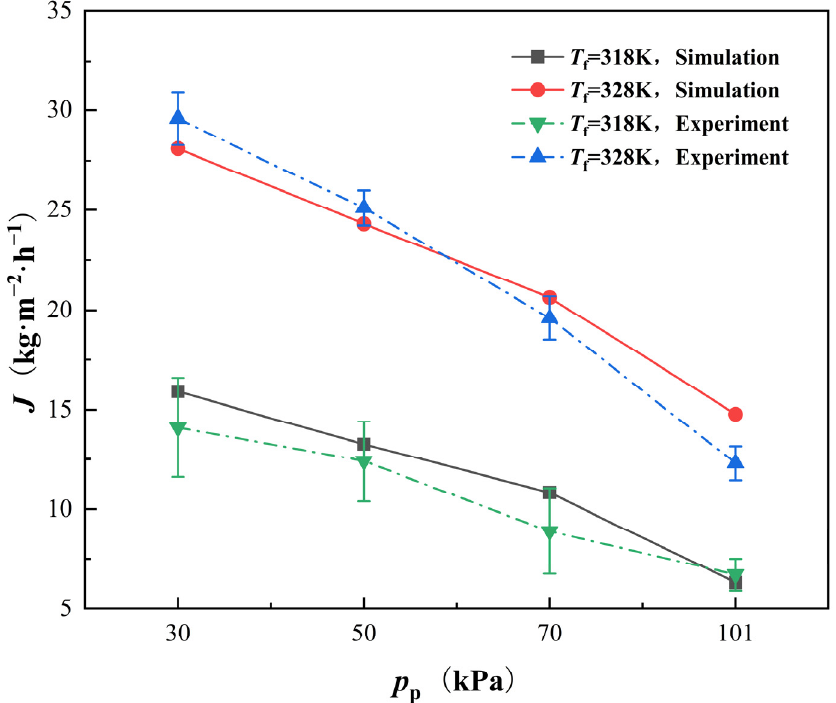
Figure 5. Comparison of simulating and experimental values of permeate flux of VEDCMD. V f = 0.56 L(min), p f = 101,325 Pa, V p =0.29 L(min), T p = 303 K, and W NaCl = 3.5%.